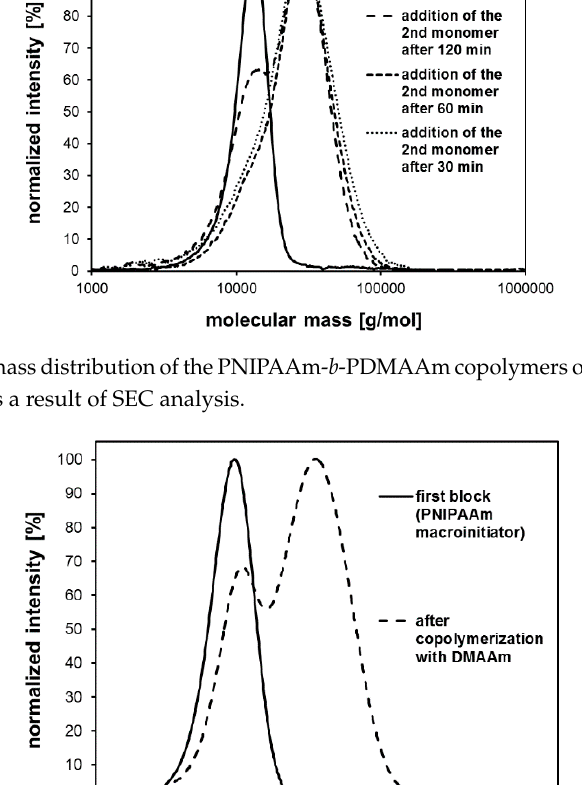
Figure5. MolecularmassdistributionofaPNIPAAm-b-PDMAAmcopolymerobtainedbypolymerizing Figure 5. Molecular mass distribution of a PNIPAAm-b-PDMAAm copolymer obtained by N,N-dimethylacrylamide (DMAAm) using a PNIPAAm polymerizing N,N-dimethylacrylamide ( DMAAm) using a PNIPAAm macroinitiator.